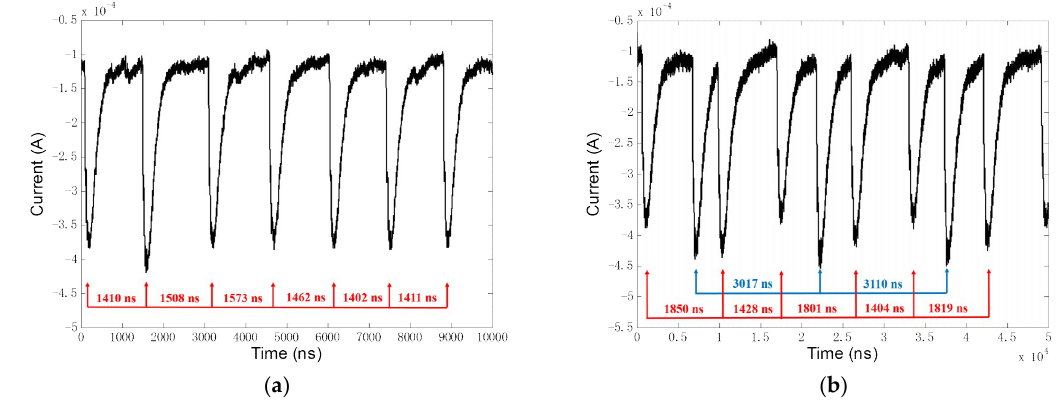
Figure 16. Negative corona discharge Trichel pulse current waveform when loading voltage is 8.6 kV: ( a ) Single needle; ( b ) Double needles.